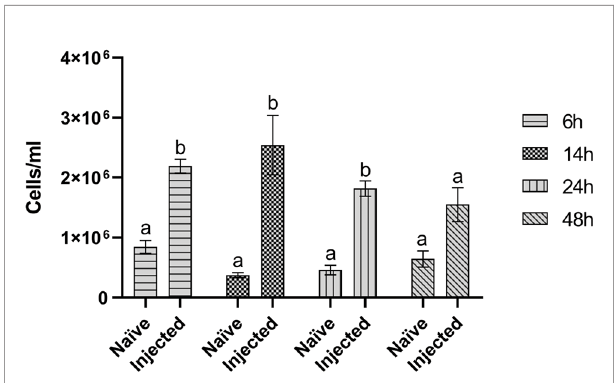
FIGURE 2 | Hemocyte counts. Hemocyte counts of naïve larvae (Naïve) and larvae infected with 10 5 CFU/ml E. coli/M. luteus mix (Injected) at different time points (6, 14, 24, and 48 hours after infection). Values represent mean ± s.e.m. Different letters indicate statistically signi fi cant differences among naïve and injected larvae (Unpaired Student ’ s t -test: for 6h t = 3.289, df = 5, p = 0.0217; for 14h t = 7.864, df = 5, p = 0.0005; for 24h t = 4.661, df = 4, p = 0.0096; for 48h t = 1.595, df = 4, p = 0.1859).